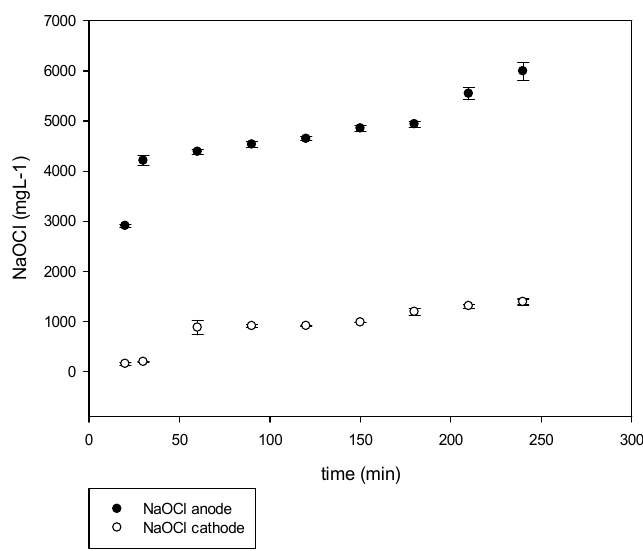
Figure 9. NaOCl production at anode and cathode in bubbling and recirculation configuration.